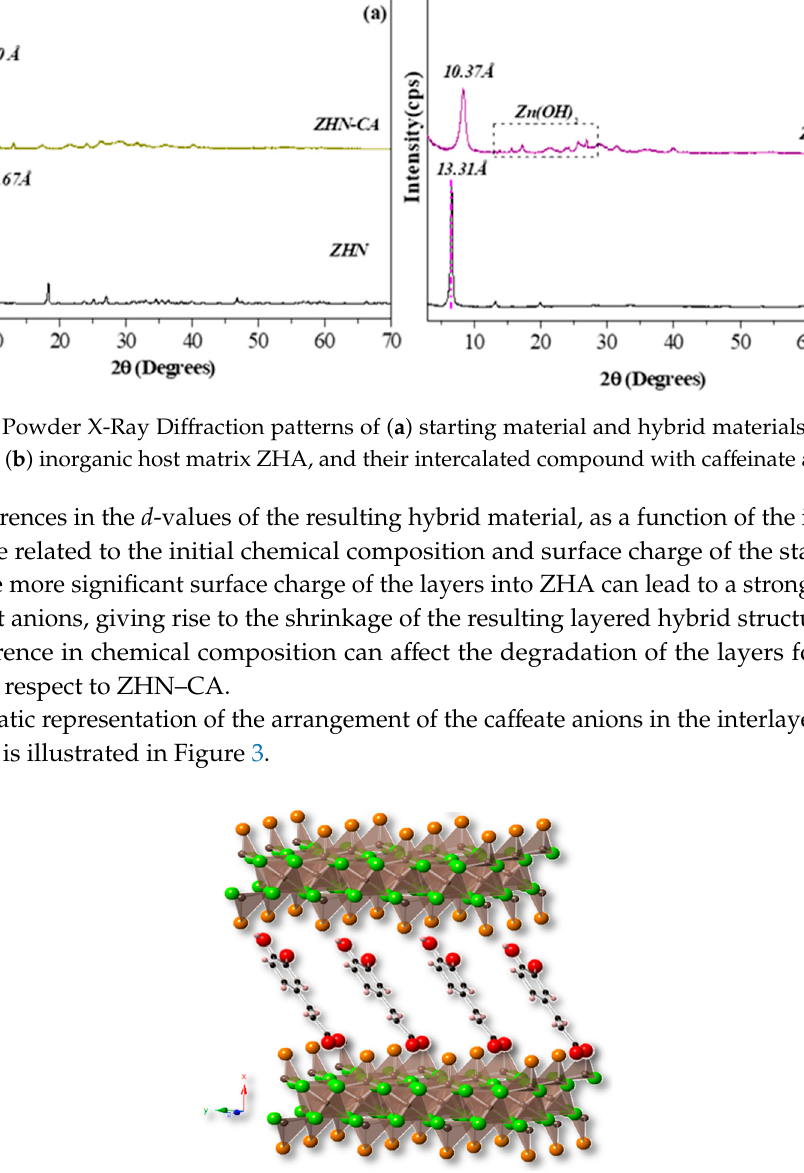
Figure 2. Powder X-Ray Diffraction patterns of ( a ) starting material and hybrid materials based on ZHN and ( b ) inorganic host matrix ZHA, and their intercalated compound with caffeinate anion.